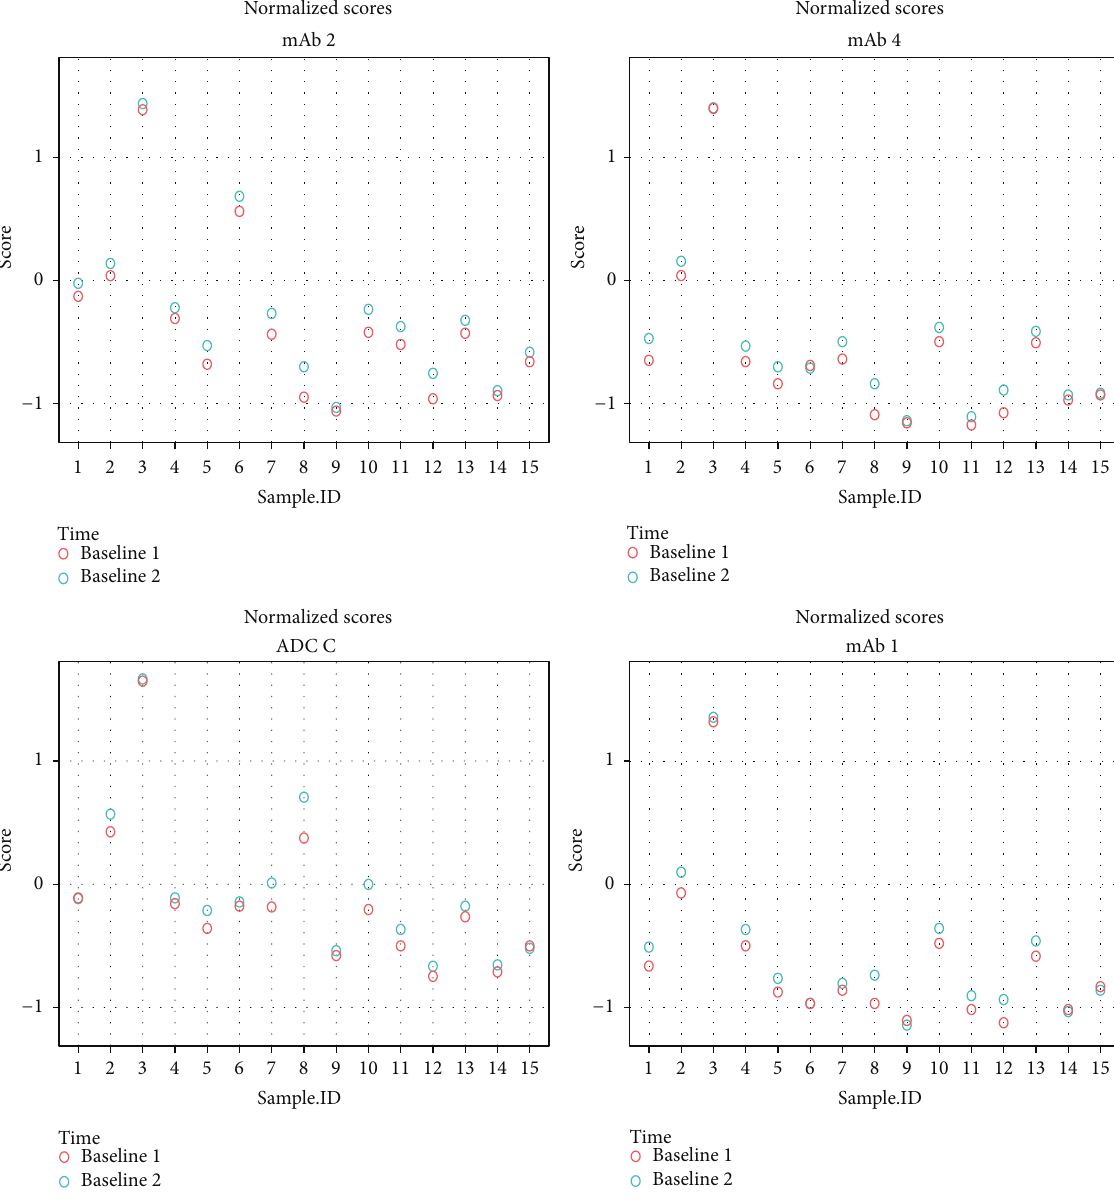
Figure 5: Normalized scores for background signal in samples from 15 cynomolgus monkeys across four biotherapeutics. Two samples taken 1 week apart from 15 cynomolgus monkeys were spiked at 5 𝜇 g/mL with ADC C, mAb 1, mAb 2, and mAb 4 and analyzed in the generic assay. This figure illustrates the difference in responses for each biotherapeutic spiked in the individual samples. Normalized scores were calculated for each sample as the log (sample signal/negative control signal) across all four